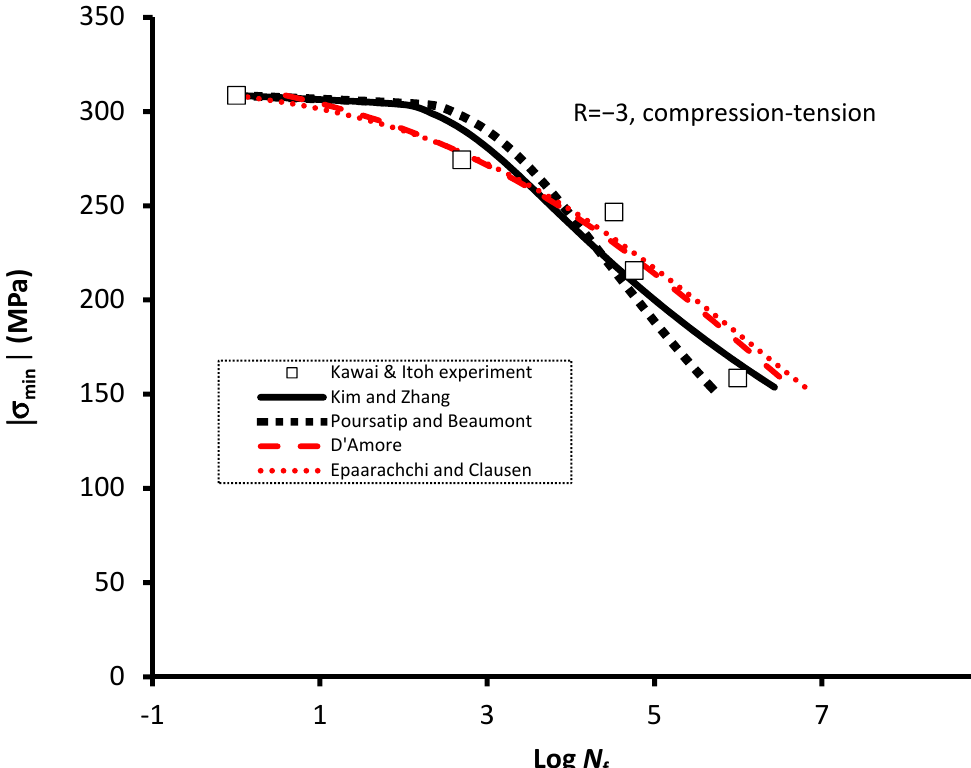
Figure 13. Kawai and Itoh experimental data at R = − 3 [22] for carbon fiber reinforced epoxy laminates with σ Uc = 807 MPa and σ uT = 1887 MPa, and S-N curves obtained from: Kim and Zhang model with α = 4.3 × 10 − 38 , β = 13.506 , and N 0 = 1; Poursatip and Beaumont model with α = 11,000 and added N 0 = 1; D’Amore model with α′ = 0.053 and β = 0.2; and Epaarachchi and Clausen model with α′ = 0.001 and β = 0.25.